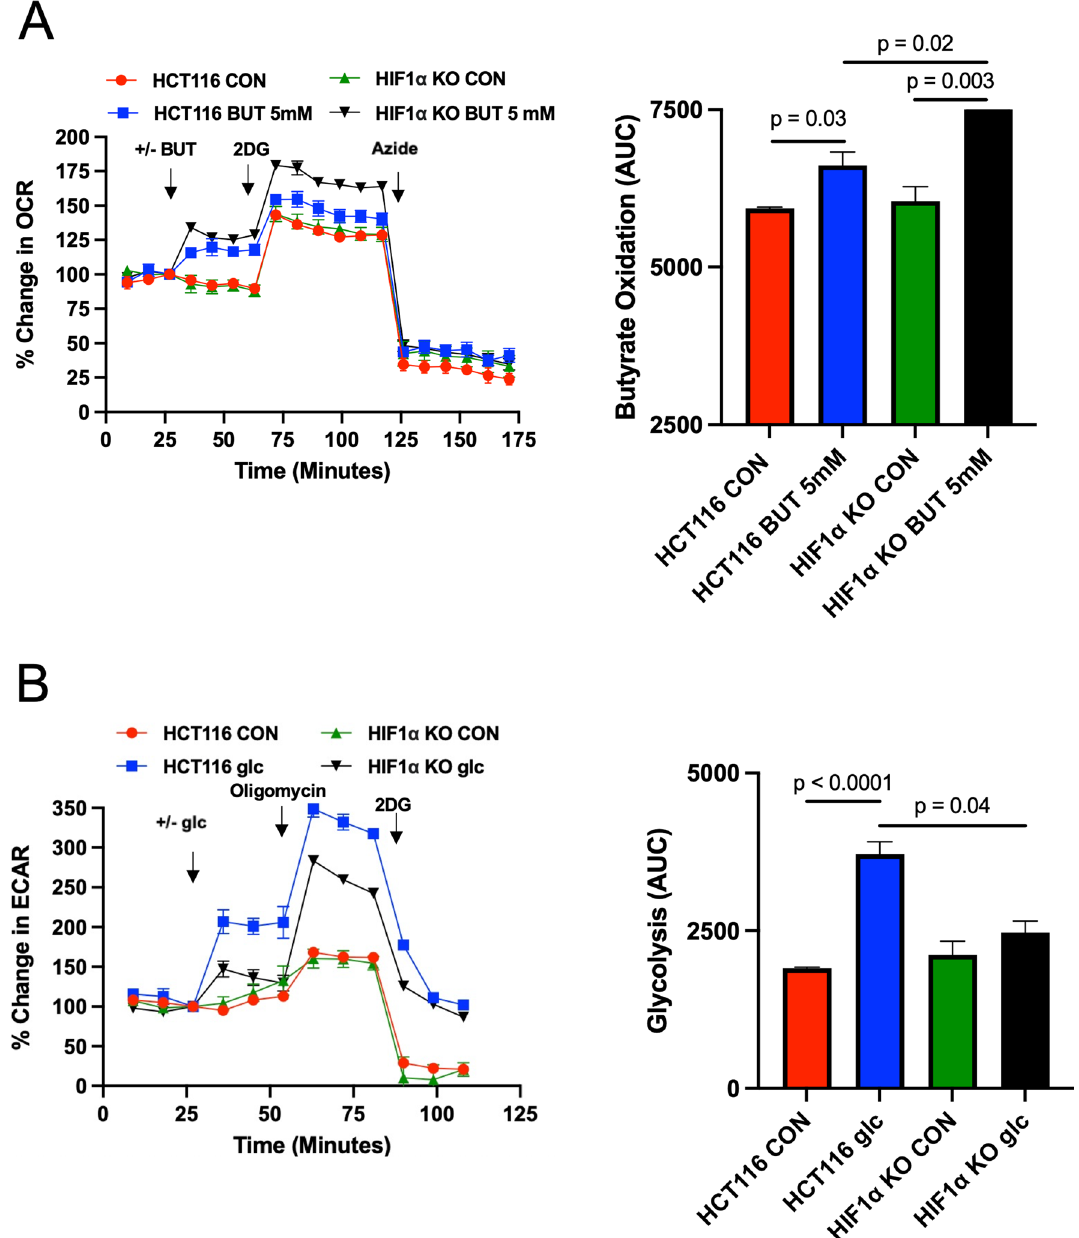
Figure 7. The role of HIF1α in regulating butyrate oxidation. ( A ) Percent change in oxygen consumption rate (OCR) relative to baseline in which HCT116 and HIF1α KO cells treated with and without butyrate (5 mM). Total contribution of butyrate toward OCR (%) is observed after injection of 2-deoxyglucose (2DG). The right panel shows the area under the curve (AUC) analysis from OCR measurements taken after 2DG injection but before azide injection. These measurements represent butyrate oxidation (arbitrary units). Data points represent the average OCR (%) over 3–5 replicates per condition for butyrate oxidation measurements. ( B ) Percent change in extracellular acidification rate (ECAR) relative to baseline in which HCT116 and HIF1α KO cells respond to glucose, 2DG, and azide. The right panel shows AUC from ECAR measurements taken after glucose injection but before 2DG injection. These measurements represent glycolysis (arbitrary units). Data points represent the average ECAR (%) over 3–5 replicates per condition for glycolysis measurements. Error bars are mean ±